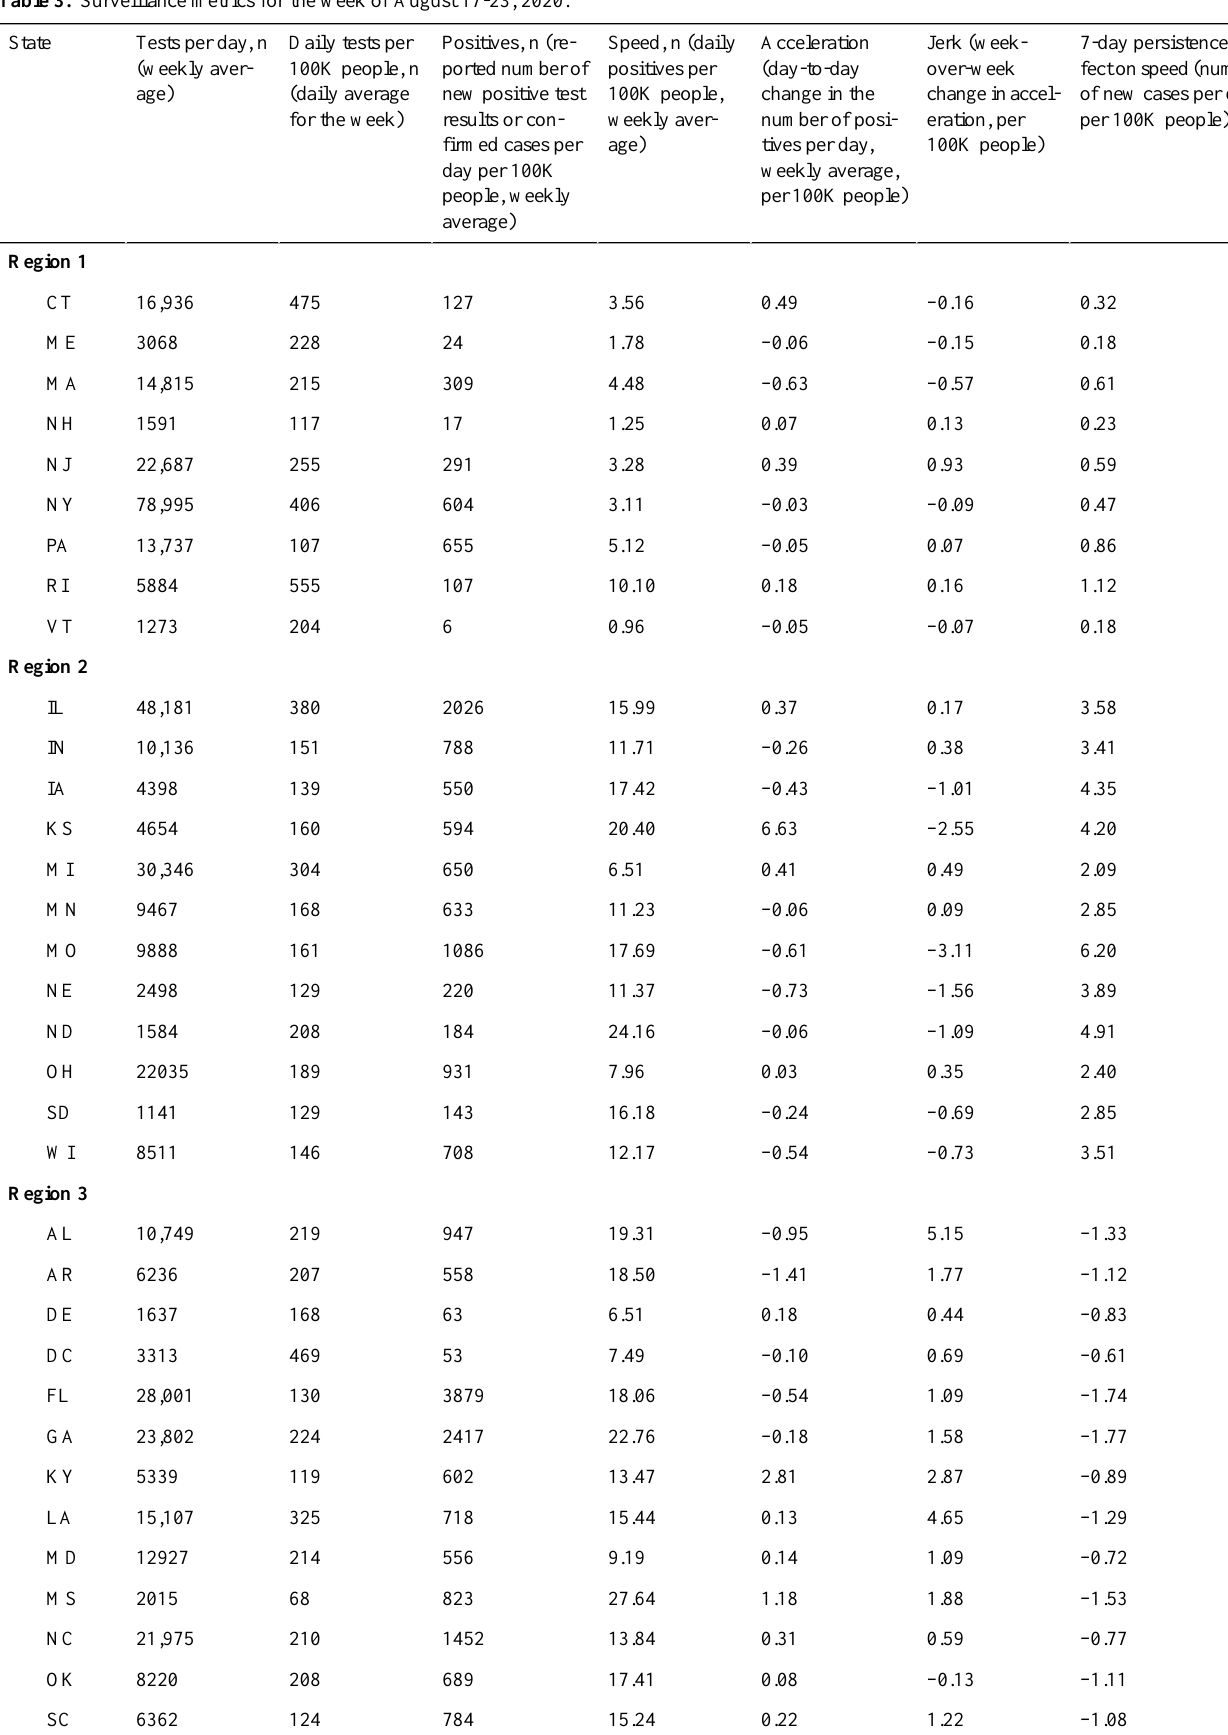
Table 3. Surveillance metrics for the week of August 17-23,